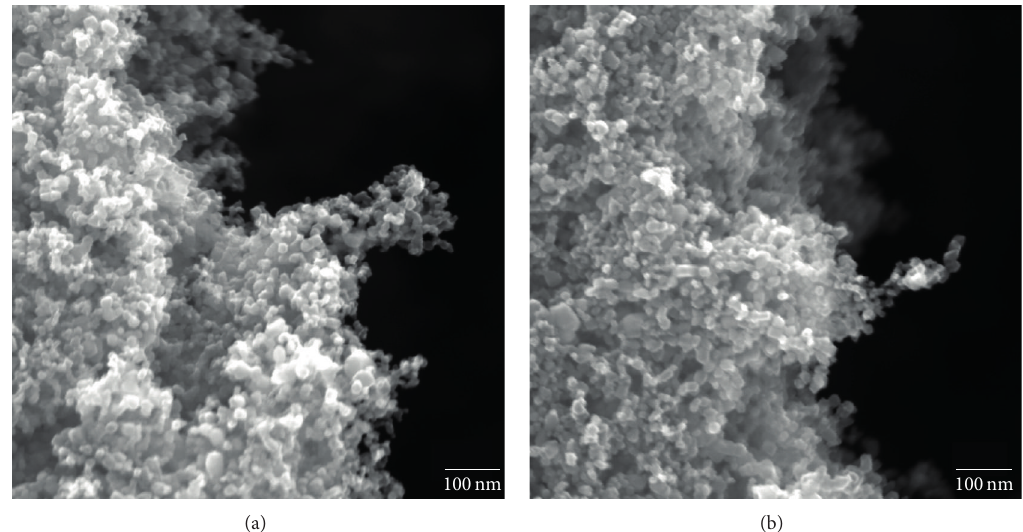
Figure2:SecondaryelectronsSEMimagesofmesoporousTiO 2 photoanodes:(a)untreatedphotoanode;(b)posttreatedphotoanodesintered at 450 ∘ C.